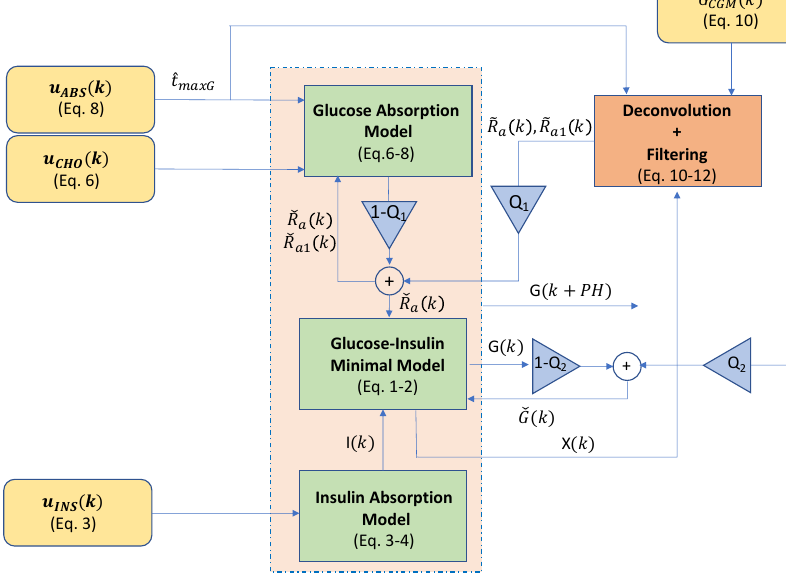
Figure 2. Block diagram corresponding to the proposed glucose forecasting algorithm. The whole diagram is executed every time a glucose value ( G CGM ) (continuous glucose monitoring (CGM)) is received. Then, the physiological model represented by the green blocks is evaluated over the prediction horizon (PH) to obtain the forecasted glucose ( G ( k + PH )